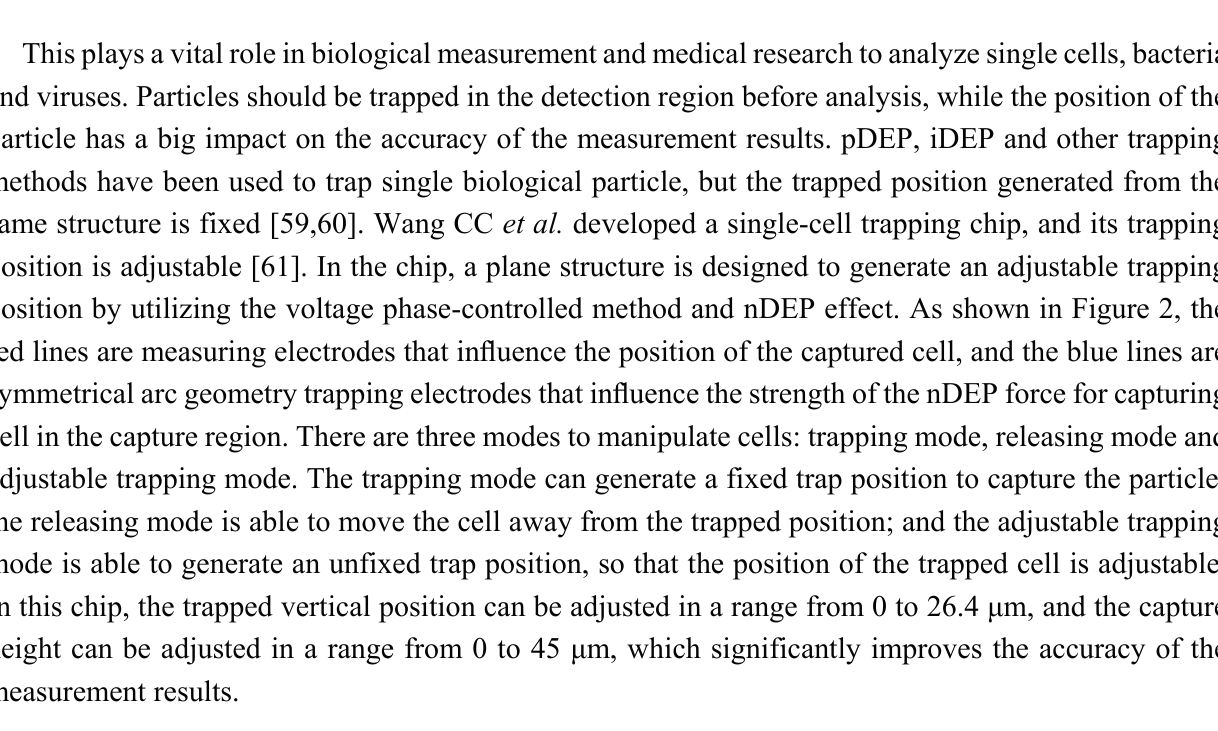
Figure 2. Schematic diagram of the adjustable trapping position chip